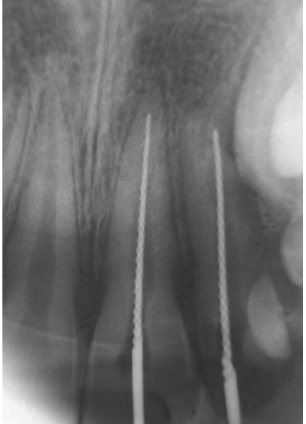
Figure 2: Periapical radiograph of the initial exploration of root canals (first session; March